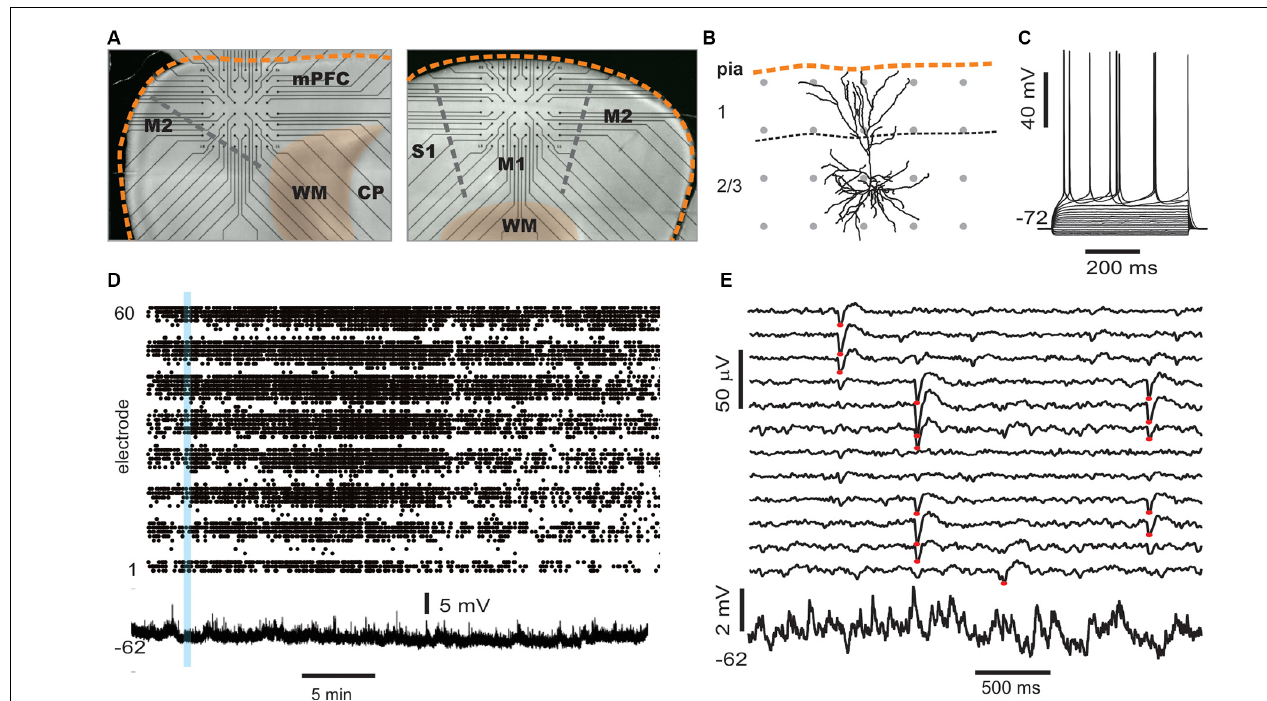
FIGURE 5 | Simultaneous multi-site LFP and whole-cell patch recordings in vitro . (A) Trans-illuminated pictures that display placement of acute coronal slices from rat cortex on a planar microelectrode array (MEA), visible as straight connection leads ending in recording electrodes ( black dots ). Left: example for medial prefrontal cortex (mPFC) recordings. The medial cortex border is oriented upwards. Right: example of somatosensory cortex (M1) recording. The dorsolateral axis is oriented upwards. Scale: inter-electrode distance is 200 µ m. Orange broken line : cortical border. WM, white matter; CP, caudate-putamen. (B) Example of a reconstructed layer 2/3 pyramidal neuro (confocal image) to illuminate size relationships between single neurons and spacing of MEA electrodes ( gray dots ). (C) Sub- and suprathreshold voltage responses to step current injections of a whole-cell patched pyramidal cell. (D) Example of spontaneous nLFP activity on the full array (electrodes 1–60 ordered in groups of eight per row) in the presence of NMDA/DA, which typically lasts for > 30 min (Stewart and Plenz, 2006). The time course of the simultaneously recorded intracellular membrane potential from a whole-cell patched neuron is displayed at the bottom. (E) Five seconds of ongoing LFP population activity recorded from a subset of MEA electrodes spanning layer 2/3 and intracellular membrane potential taken from the period in panel ( D ; blue bar ) at higher spatiotemporal resolution. Red dots indicate suprathreshold nLFPs. Note the absence of any apparent, straightforward relationship between single-neuron activity and